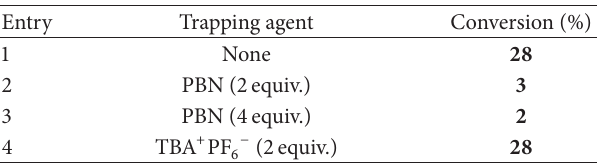
Table 3: Radical/electron trapping experiments a (see Scheme